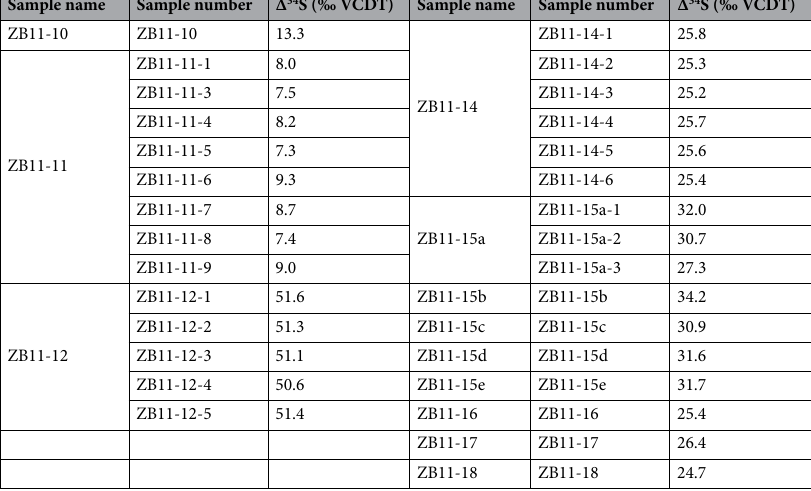
Table 2. Sulfur isotope composition of pyrite nodules in Taoying, Guizhou Province, southern China; sampled in 0.3 to 1.0 cm spatial resolution.